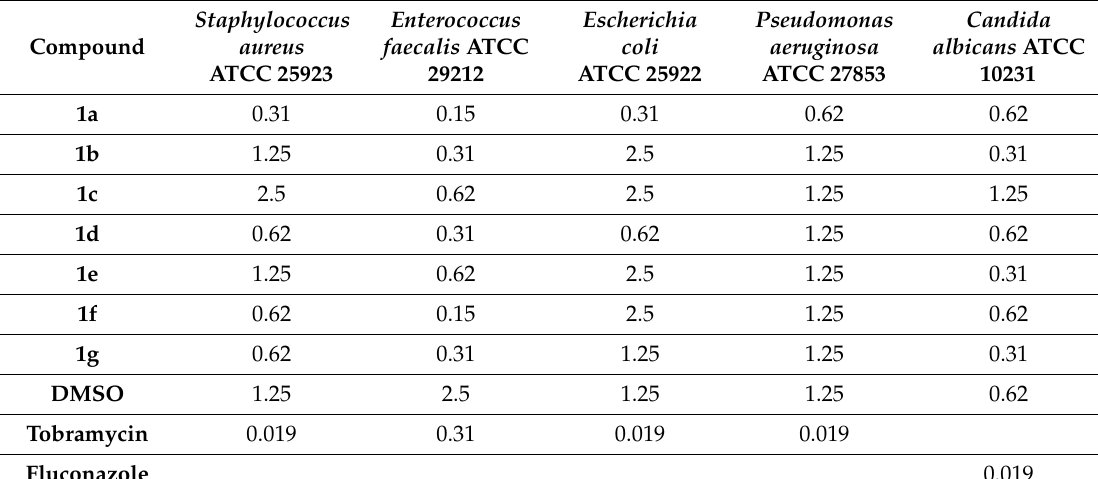
Table 5. Results of the quantitative assay of MIC for the compounds 1a – g (MIC values expressed in mg /